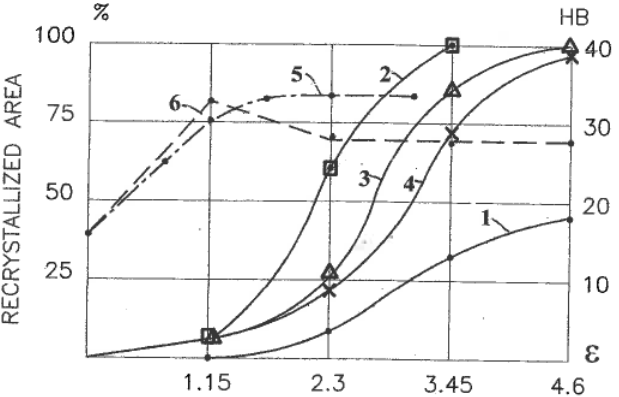
Figure 7. Dynamically recrystallized area (%) (solid lines) and hardness HB (dashed lines) of pure Al (99.9992%) versus effective strains ε : 1—rolling; 2—ECAE, Route D (B C ); 3—ECAE, Route A; 4—ECAE, Route C; 5—rolling; 6—ECAE.